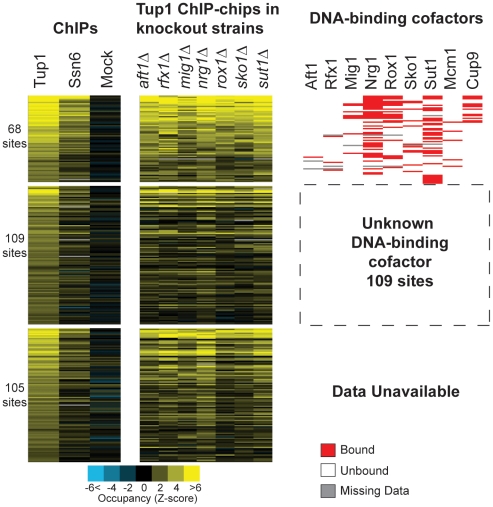
Only a fraction of sites bound by Tup1 in rich media are co-occupied by known cofactors.282 sites bound by Tup1 during exponential growth in rich media were identified by ChIP-chip using a TAP-tagged protein and whole-genome tiled microarrays. For each target, the Z-score for the highest array element within the peak, as identified by ChIPOTle [55] is shown. Mock experiments performed in a wild-type strain lacking a TAP-tagged protein are also shown. The 282 Tup1 bound sites were sorted by p-value and split into three groups: 68 sites that are co-occupied by a known Tup1 recruiting protein (top), 109 sites not co-occupied by a known recruiting protein (middle), and 105 sites with no available cofactor binding data. Tup1 binding sites without cofactor data were located in regions of the genome that were not present on the microarrays used in the cofactor binding study [30]. Tup1 binding was also measured by ChIP-chip for strains carrying deletions of the known Tup1 recruiting cofactors Aft1, Rfx1, Mig1, Nrg1, Rox1, Sko1, and Sut1. DNA-binding cofactors are shown on the right, with occupancy as determined by ChIP-chip indicated in red (P<0.001 [30]). The following number of biological replicates were performed: Tup1, 21; Ssn6, 2; Mock, 4; recruiter deletion strains, 3–4.